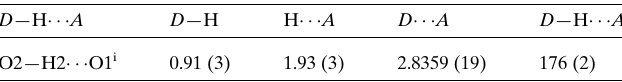
Table 2 Hydrogen-bond geometry (A˚ , (cid:2) ) for (V).